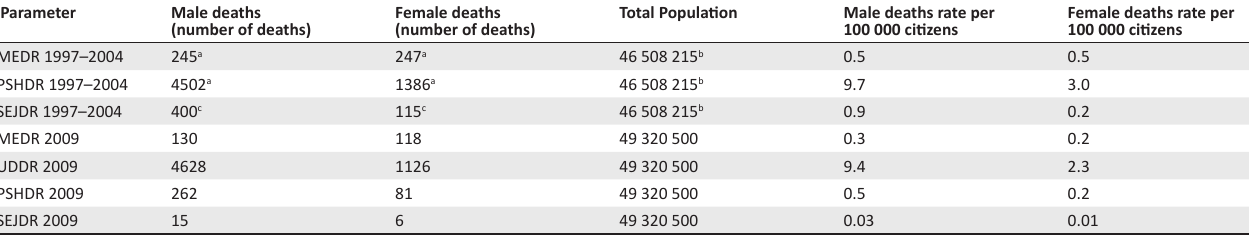
TABLE 5: The average GDR values for the 1997–2004 period as calculated using Equation 5. Parameter Male deaths (number of